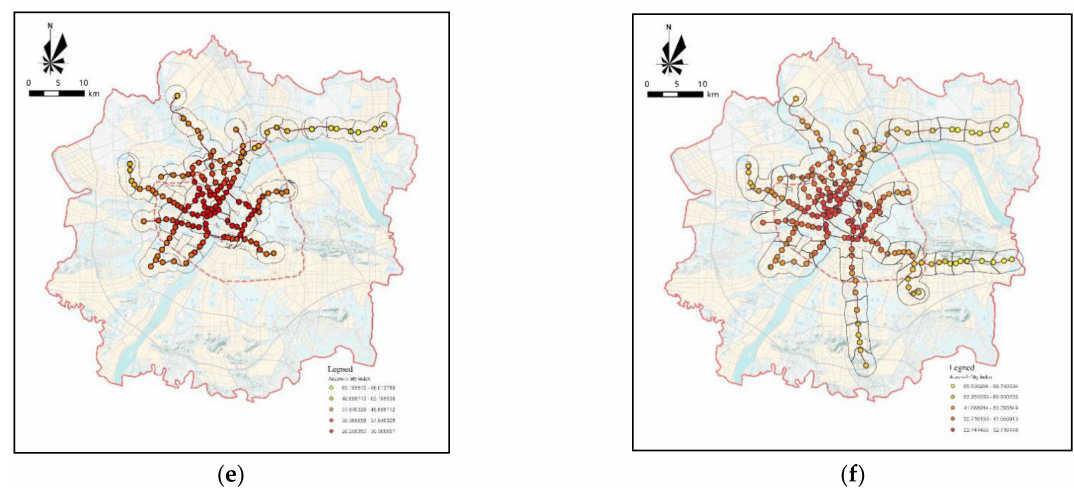
Figure 4. Evolution of spatial distribution form of the weighted time accessibility index of the Wuhan rail transit network. ( a ) 2014; ( b ) 2015; ( c ) 2016; ( d ) 2017; ( e ) 2018; ( f ) 2019.